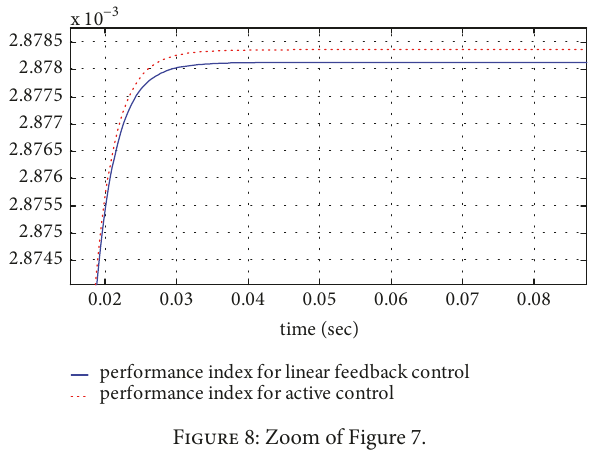
Figure 8: Zoom of Figure